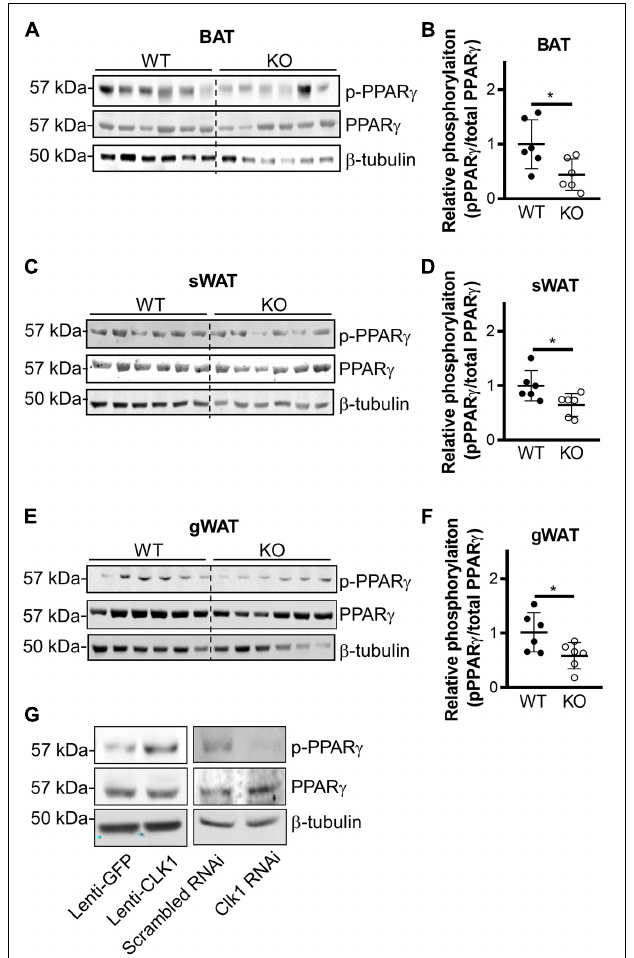
FIGURE 6 | CLK1 deficiency reduces phosphorylation of PPAR γ on Ser273. (A–F) Male CLK1 KO (KO) or wildtype (WT) mice were fed a HFD for 8 weeks, starting at 8 weeks of age. Western blot (left panel) and quantitative densitometry data (right panel) showing phosphorylation of PPAR γ in BAT (A,B) , sWAT (C,D) , and gWAT (E,F) in WT and KO mice at the end point of the 8-week’s HFD feeding. Data shown as mean ± SD, * p < 0.05. (Unpaired Student’s t test). (G) Western blot showing phosphorylation of PPAR γ in immortalized mouse brown adipocytes with CLK1 overexpression (10 MOI of lentivirus, Lenti-GFP as control) or knockdown (10 nM of siRNA, scrambled siRNA as